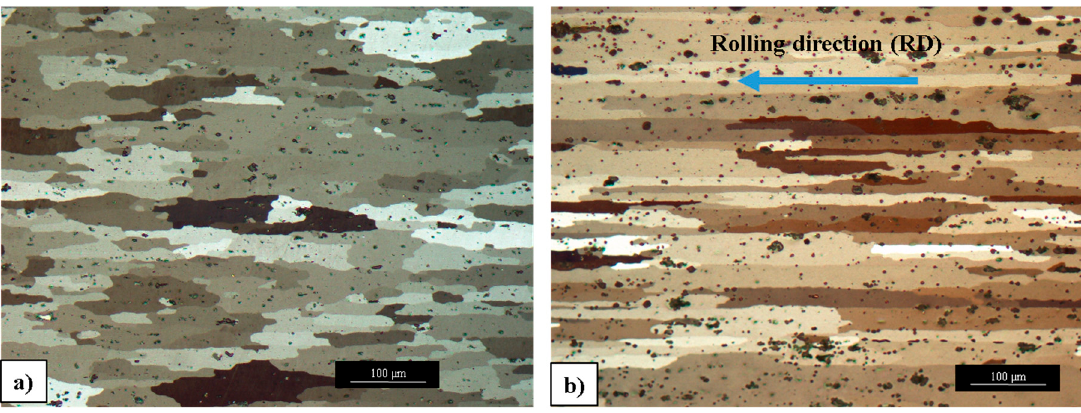
Figure 3. Grain structure in AA2024-T4 polarized light micrographs showing ( a ) deposit cross-section (ST-LT plane), ( b ) ST-RD.